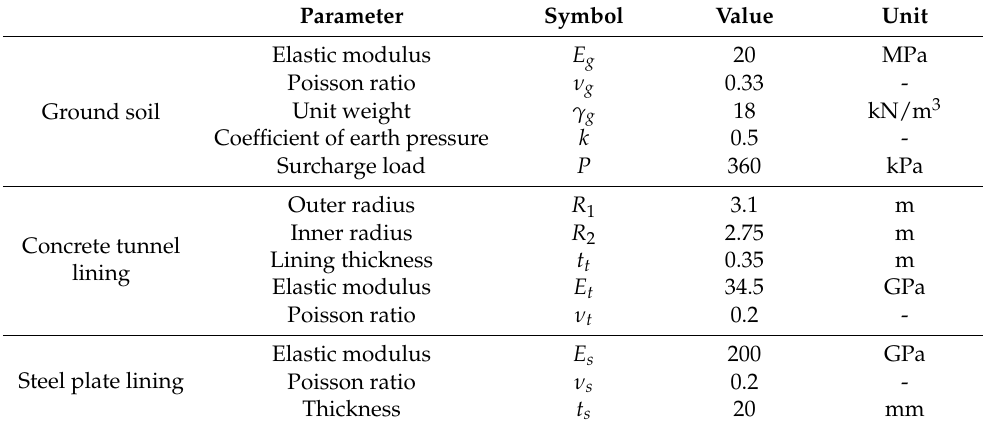
Table 1. Parameters of each material in the proposed model.